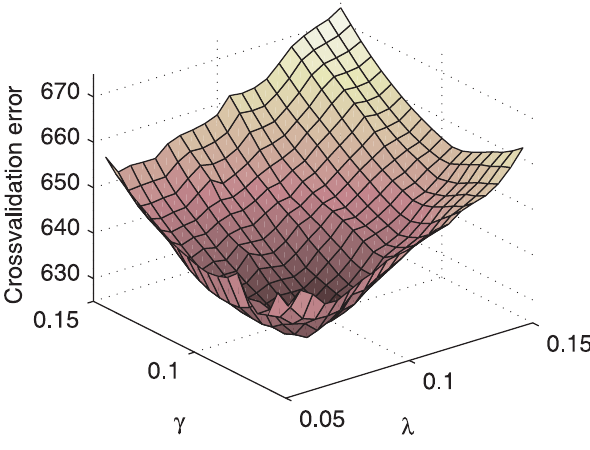
Figure 3. Cross-validation error surface over a grid of regularization parameters ( l , ª ) from G w Fla s so . Our goal is to find values for l and c that give the lowest cross-validation error. We use a gradient-descent type of search algorithm to explore this surface of cross-validation error.